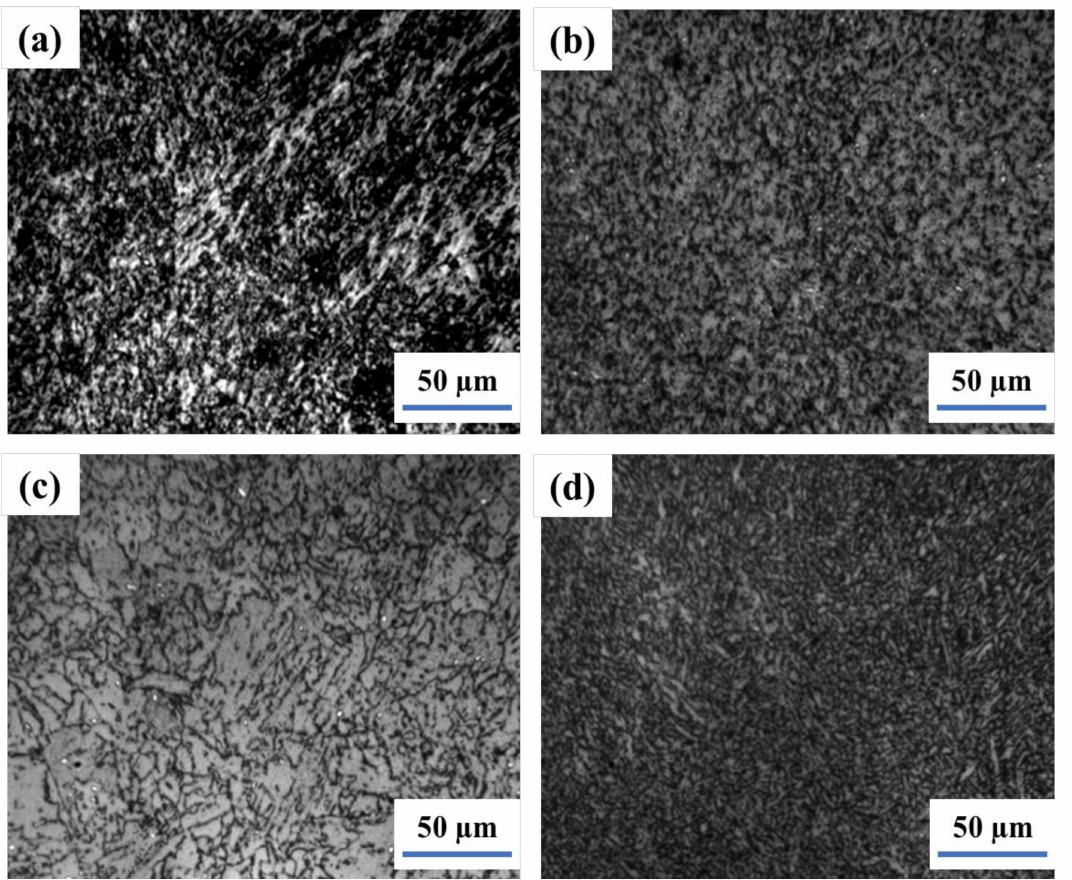
Figure 7. The M − A of the weld joint tempered at 620 ◦ C, at 660 ◦ C after IN: 620 ◦ C − weld ( a ) and HAZ ( b ); 660 ◦ C − weld ( c ) and HAZ ( d